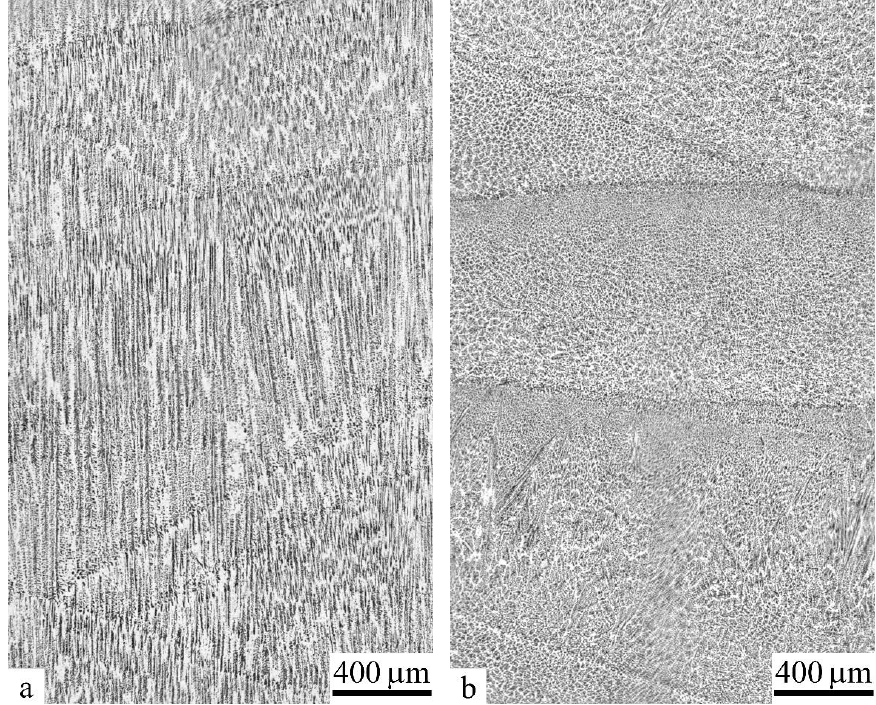
Figure 6. General view of the microstructure of the metal deposited without ( a ) and with ( b ) layer- by-layer